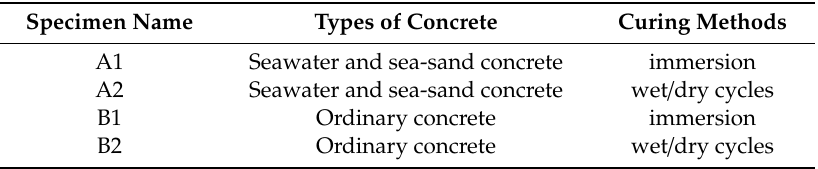
Figure 2. Images of curing setup for test specimens; ( a ) Setup of the immersion process, ( b ) Setup of the wet/dry cycles.